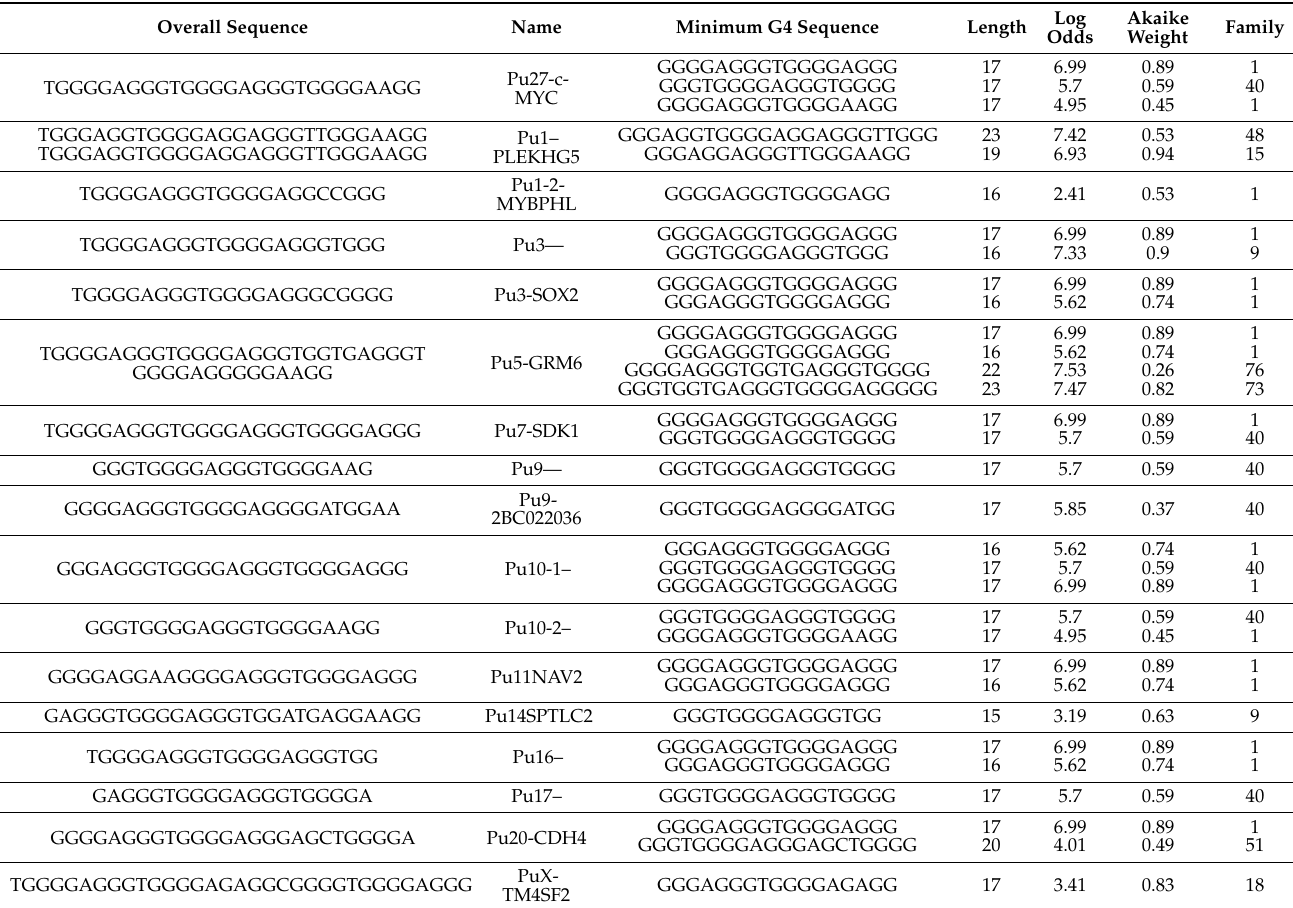
Table 4. Family prediction for previously identified Pu27 family of G4